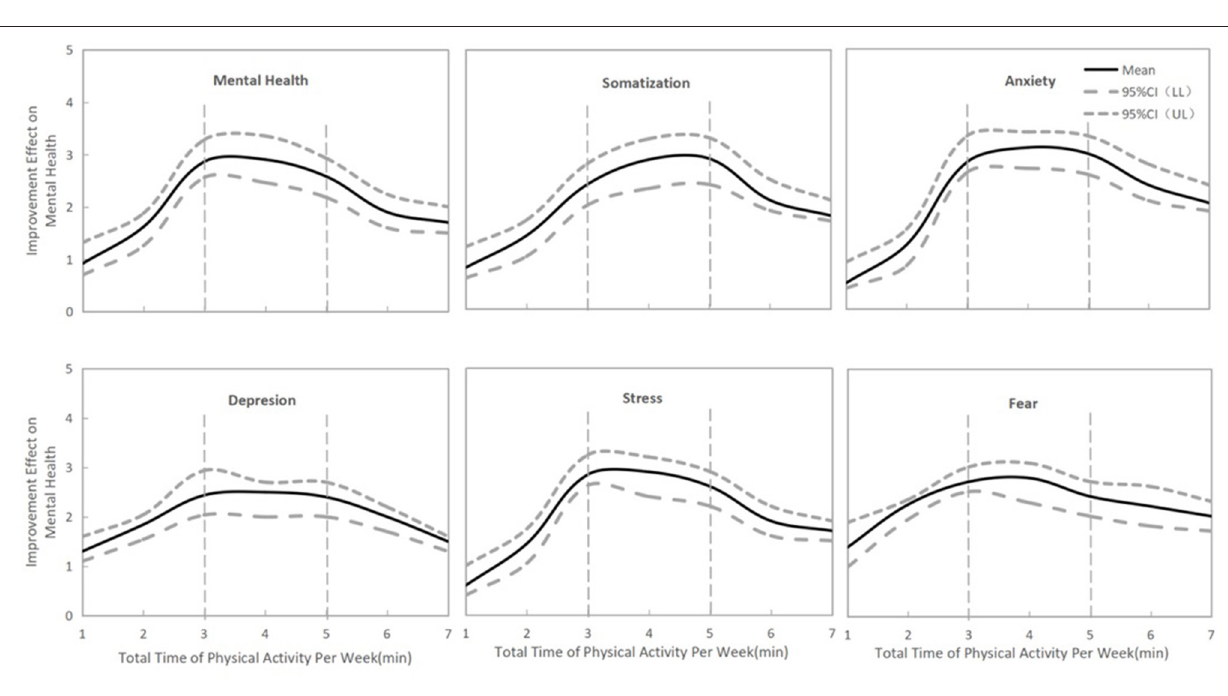
FIGURE 7 | The association between mental health improvement and exercise duration per